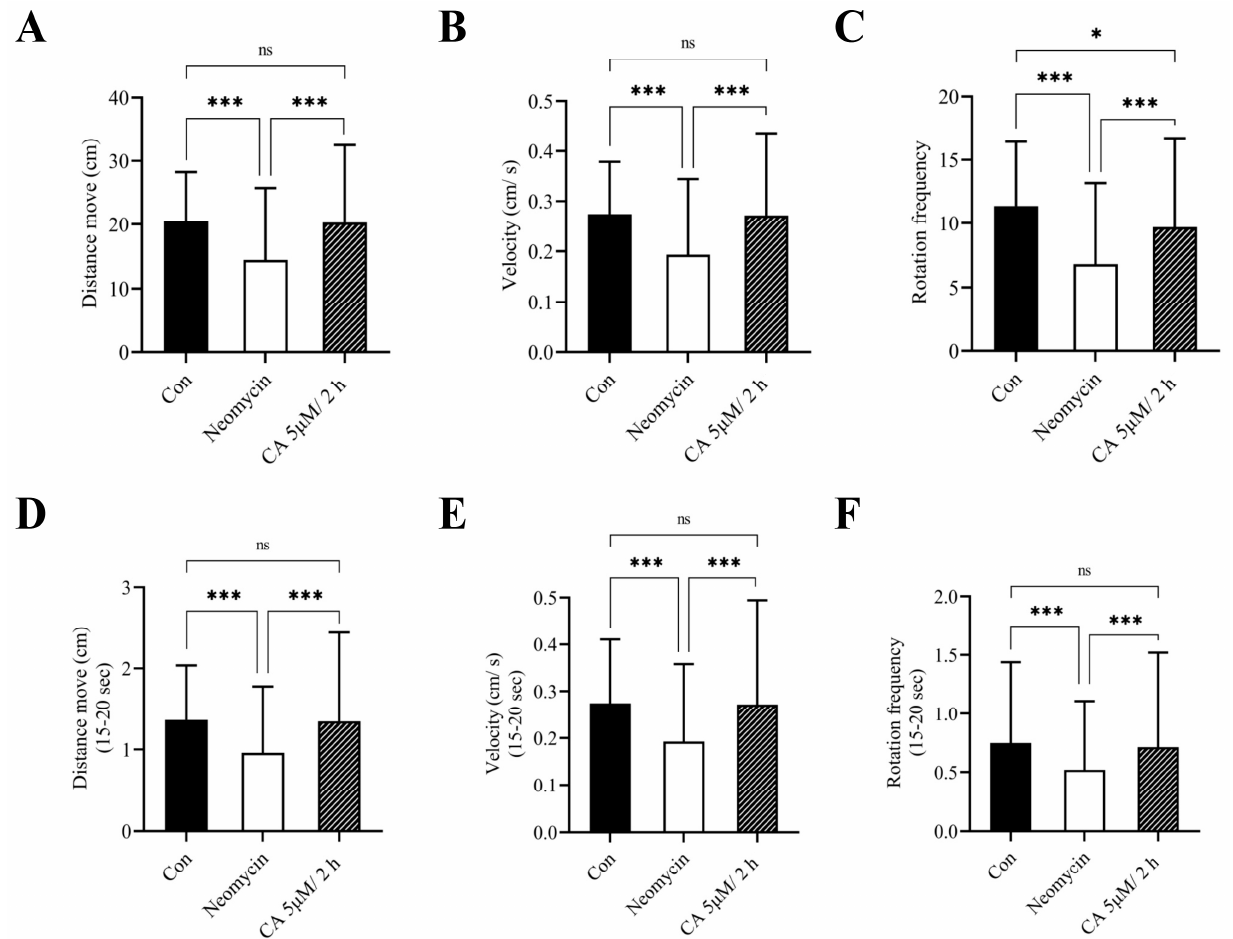
Figure 4. Otoprotective effects of CA on locomotor behavior of transgenic zebrafish larvae. After the exposure period, the transgenic zebrafish larvae were individually transferred into a 12-well plate and examined the behavioral parameters including ( A ) distance moved, ( B ) velocity, and ( C ) rotation frequency in response to sound and vibration stimulus caused by the tapping device. Short-time ( D – F ) escapes response within 15 s were confirmed and consisted of ( A – C ). All values of experimental groups were presented as mean ± SD. * p < 0.05, *** p < 0.001 and ns, no significant difference as the comparison between indicated group.